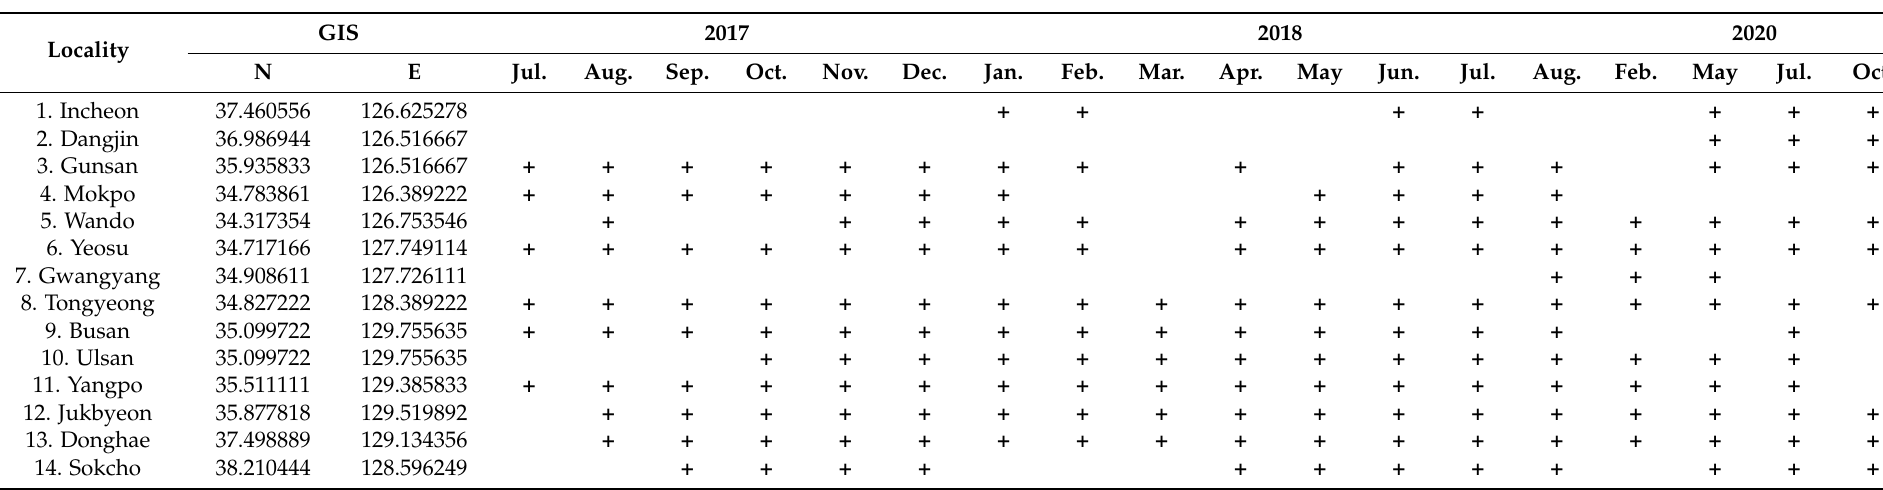
Table 4. Results of settlement plate monitoring of two-toned B. diegensis in 14 harbors of South Korea from July 2017 to October 2020.